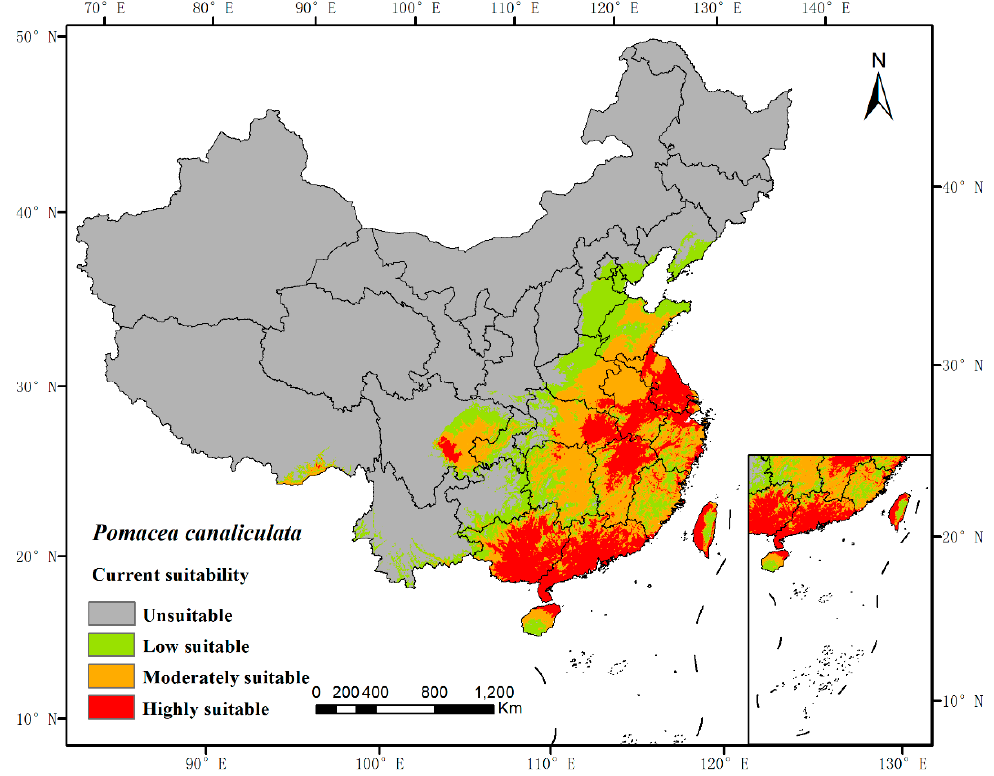
Figure 2. MaxEnt model predicted the current potential habitat suitability of Pomacea canaliculata in China. The base map was obtained from the Ministry of Natural Resources of China (http://bzdt.ch.mnr.gov.cn/index.html, accessed on 5 November 2021).